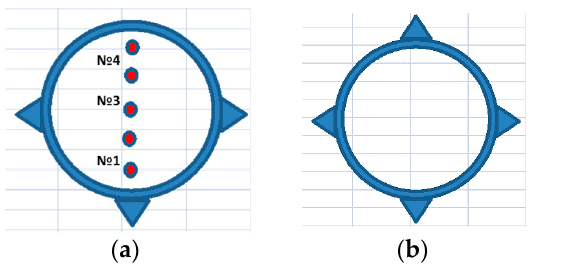
Figure 13. ( a ) T-shaped mounting scheme of ultrasonic exciters on the pipe; ( b ) The “cross” mounting scheme.